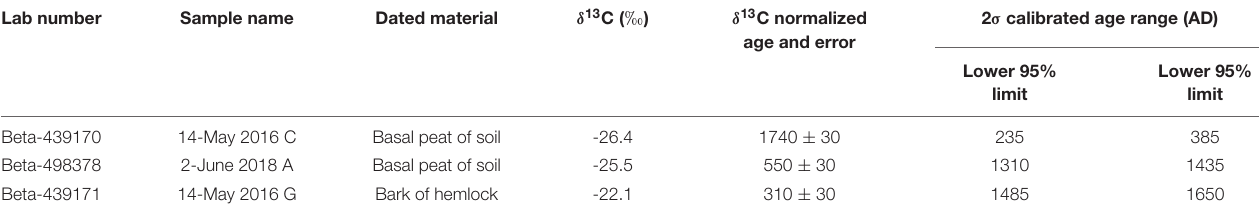
TABLE 1 | Radiocarbon dates reported in the